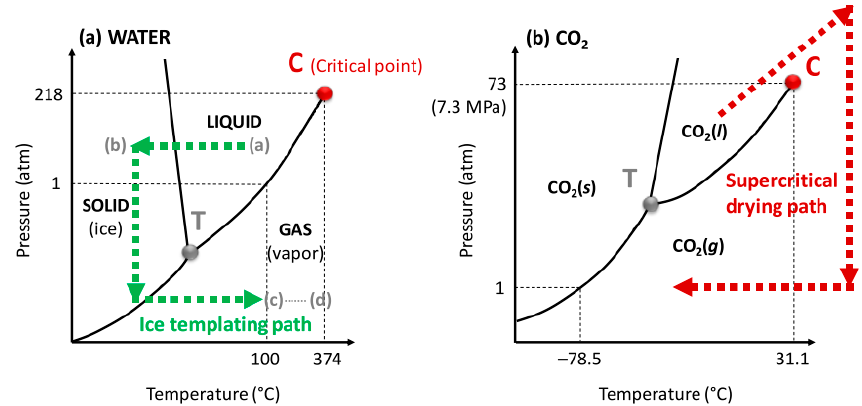
Figure 2. Phase diagrams of freeze-drying ( a ) and supercritical-drying ( b ) superposed on water and CO 2 , respectively. Reproduced from from Lavoine & Bergström [10], licensed under a Creative Commons Attribution Non-Commercial 3.0 Unported License .